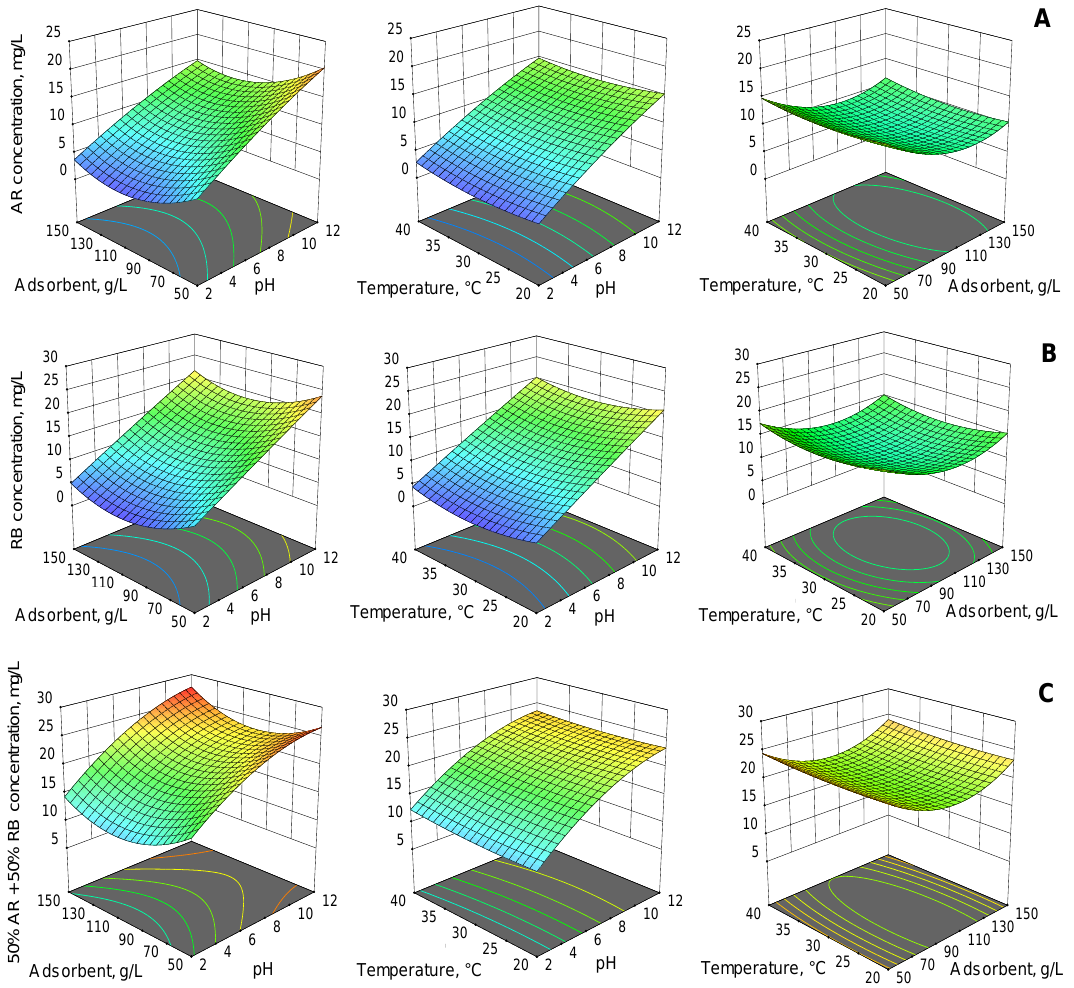
Figure 6. Aggregate impact of pH, adsorbent dose, and temperature on final concentration of AR ( A ), RB ( B ), and 50% AR + 50% RB ( C ).